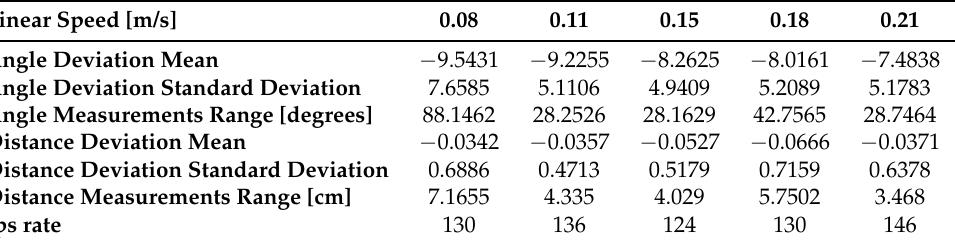
Table 8. Linear speed variation results summary with a 160 × 120 pixels image resolution, and a 30 × 10 pixels size rectangular kernel. Speed values lower than 0.21 m/s.